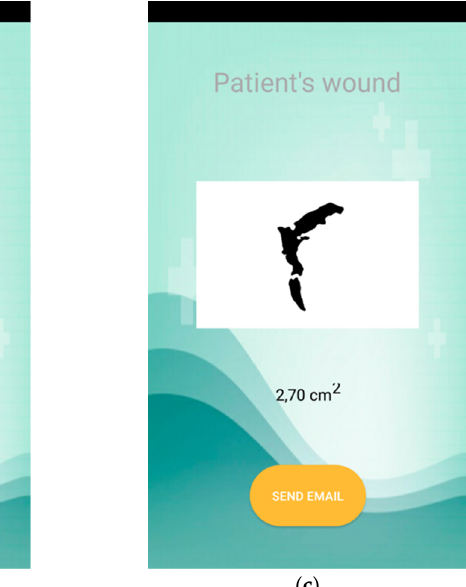
Table 4. Wound area measured by the mobile application. Figure